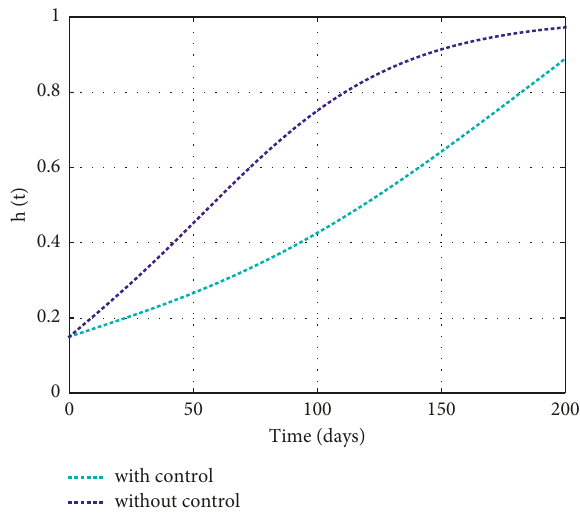
Figure 9: Simulation of HIV-only model with and without controls.